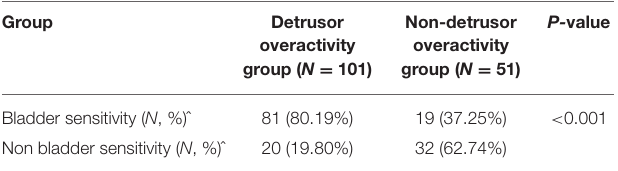
TABLE 4 | Comparison of bladder sensitivity between detrusor hyperactivity group and non-detrusor hyperactivity group.